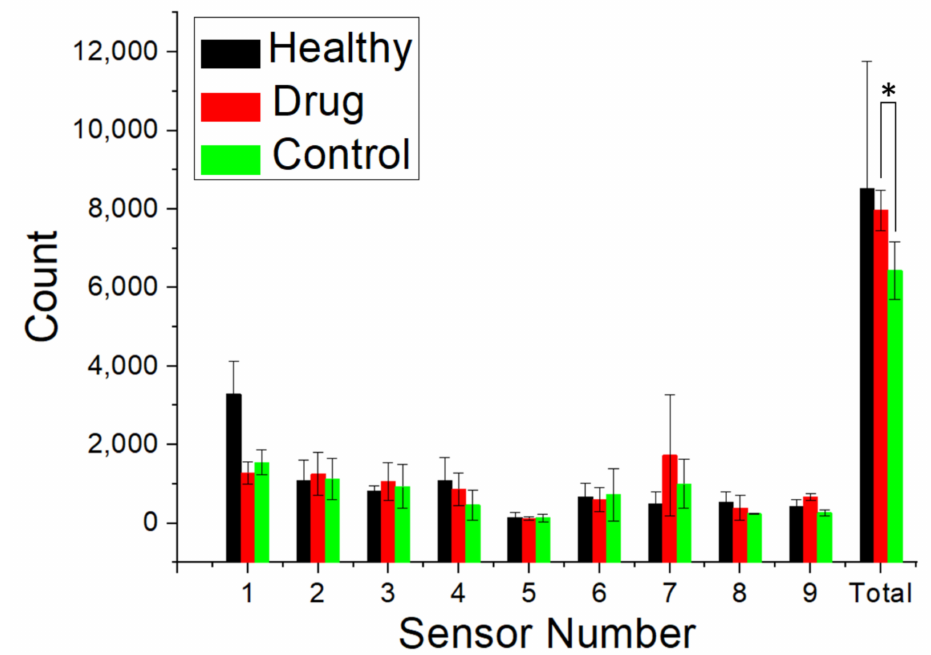
Figure 6. Activity counts of the rabbits in the healthy, doxycycline-loaded, and control (surgery only, no membrane) groups (* p < 0.05). The photoelectric switch sensors were triggered 8519 ± 3235, 7964 ± 510, and 6437 ± 732 times in the healthy, doxycycline-loaded, and control (surgery only, no membrane) groups, respectively. Rabbits undergoing allograft Achilles tendon reconstruction with a doxycycline-loaded, biodegradable, nanofibrous membrane had similar levels of activity to healthy rabbits and higher activity levels compared to control